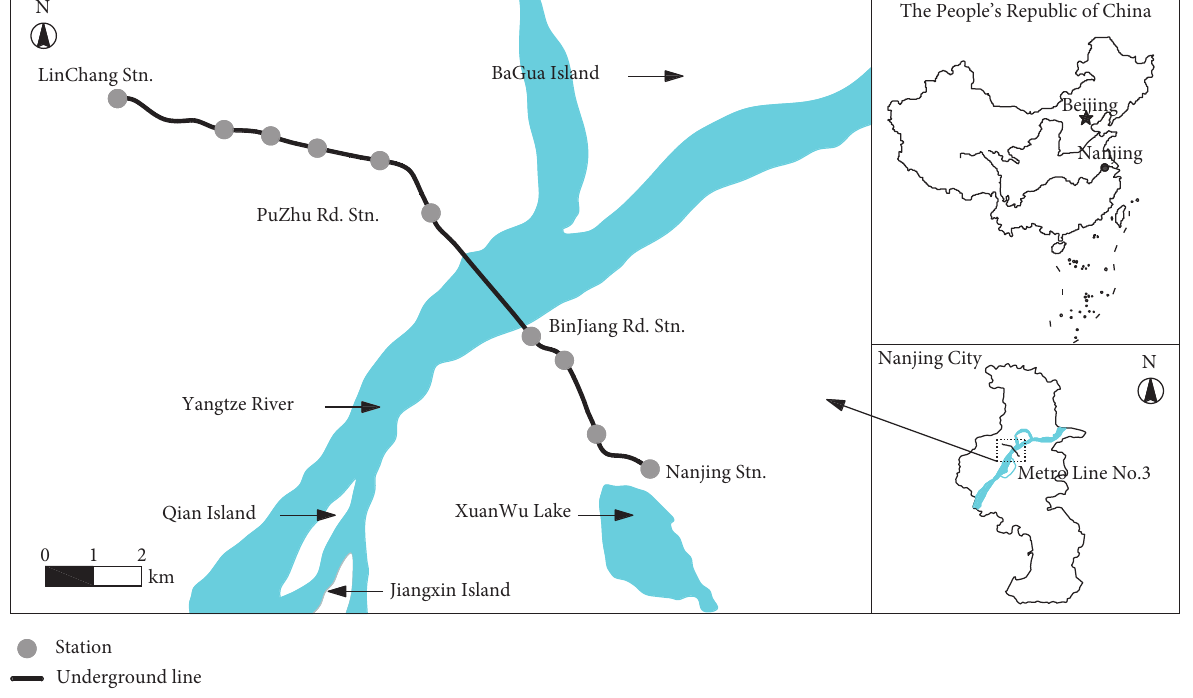
Figure 1: Location of the